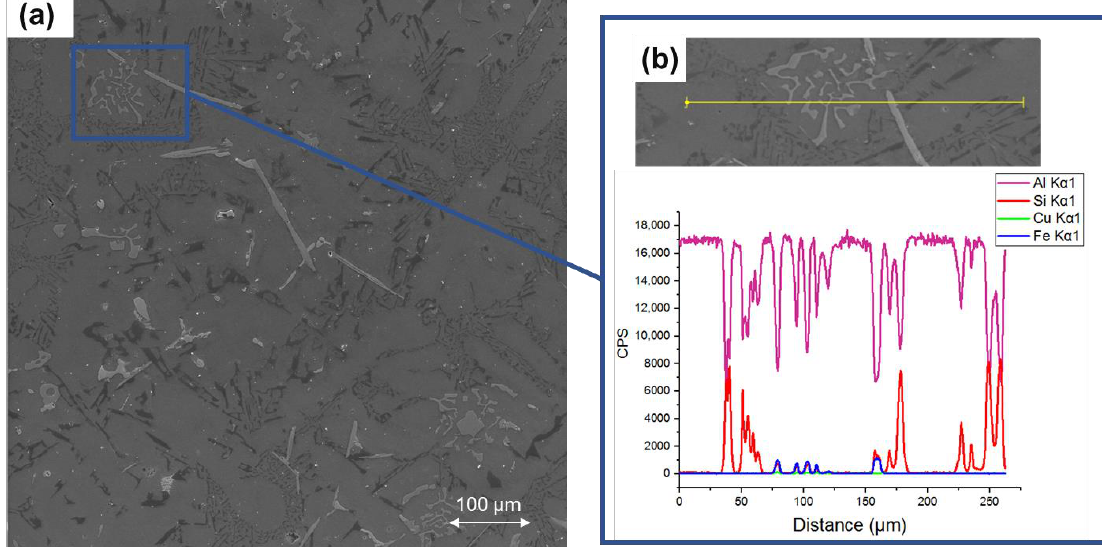
Figure 3. ( a ) A332 Secondary electron image of Chinese-script phase with; ( b ) corresponding EDS line scan showing the elements of this phase 200× present in the sample without grain refiner.